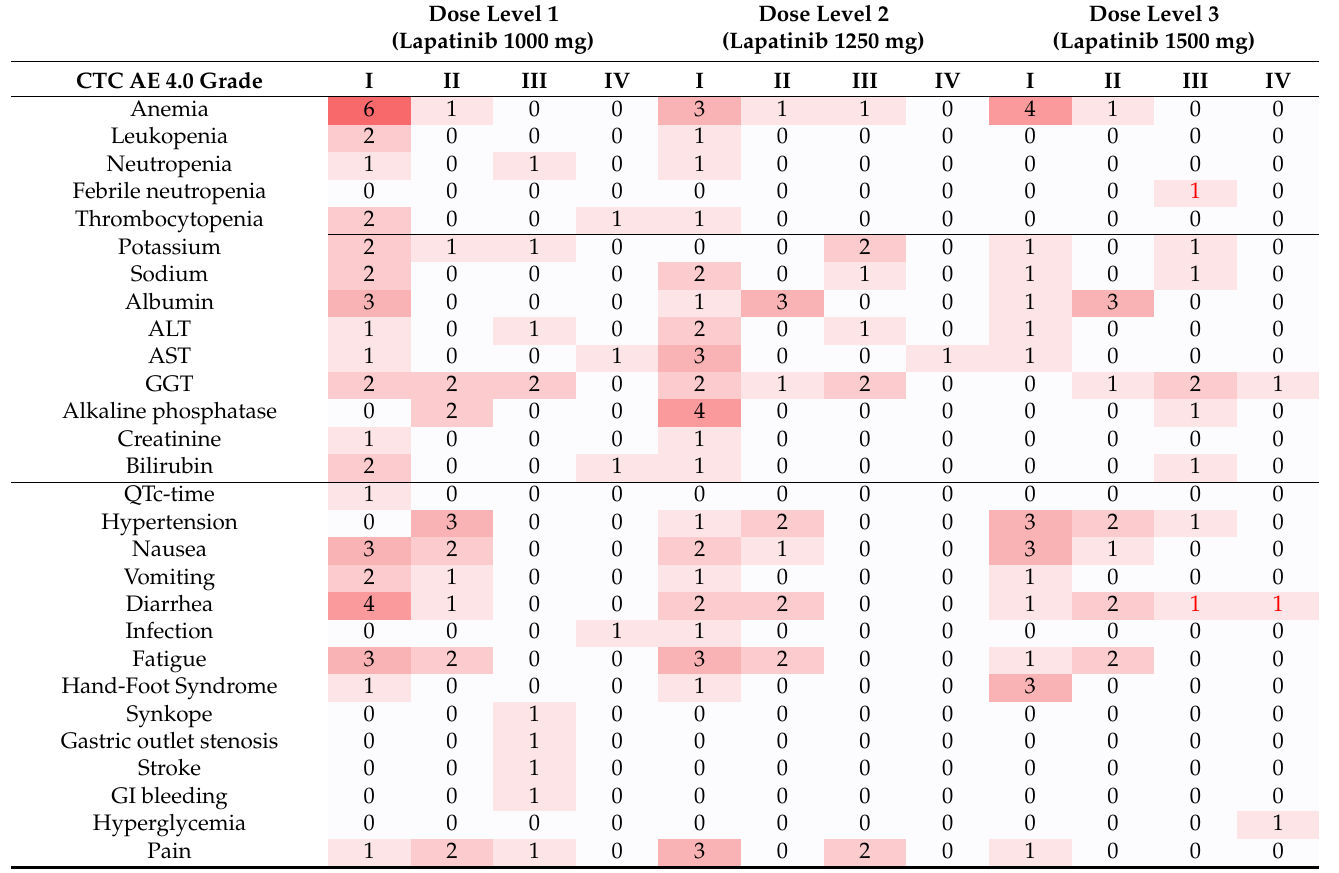
Table 2. Toxicities in cycle 1, number of maximum toxicities per cycle and